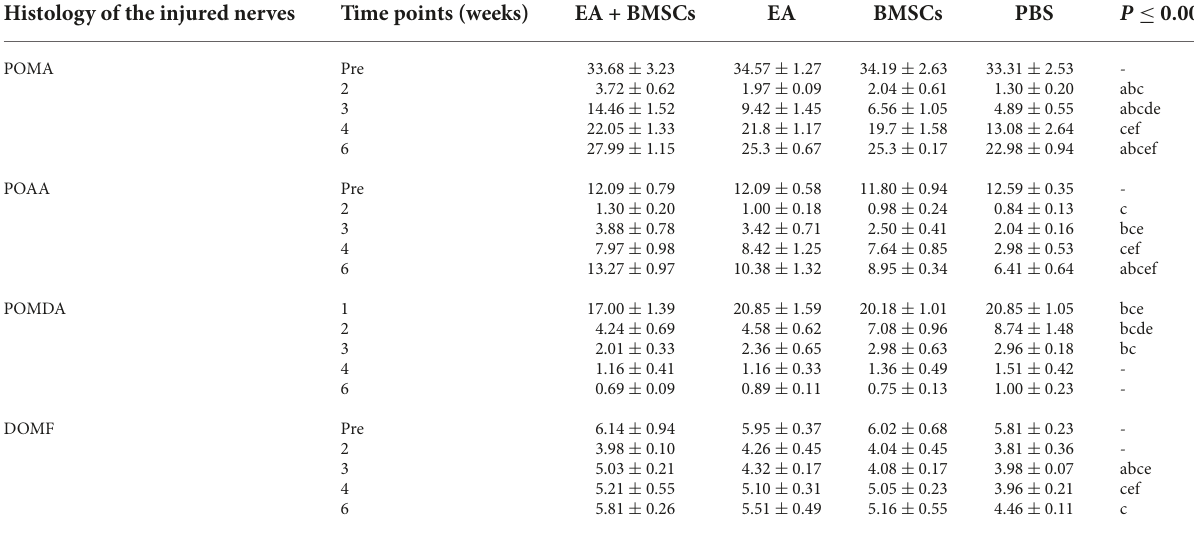
TABLE 3 Histological characterizations in EA + BMSCs, EA, BMSCs, and PBS (mean ± SD). Histology of the injured nerves Time points (weeks) EA + BMSCs EA BMSCs PBS P ≤ 0.008 POMA